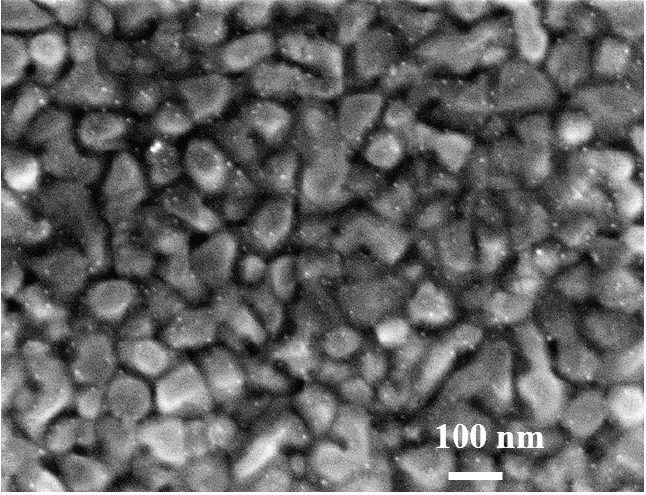
Figure 2. Field emission gun scanning electron microscopy (FEG-SEM) image of the gold electrode functionalized by silver nanoparticles (E Au/AgNPs ). The functionalization conditions correspond to a silver precursor concentration of 0.04 mol ∙ L − 1 , and a hydrogenolysis duration of 1 min. The image shows small white dots which represent the very small AgNPs and the Au grains (average size ca. 150 nm) of the gold electrode (E Au ).